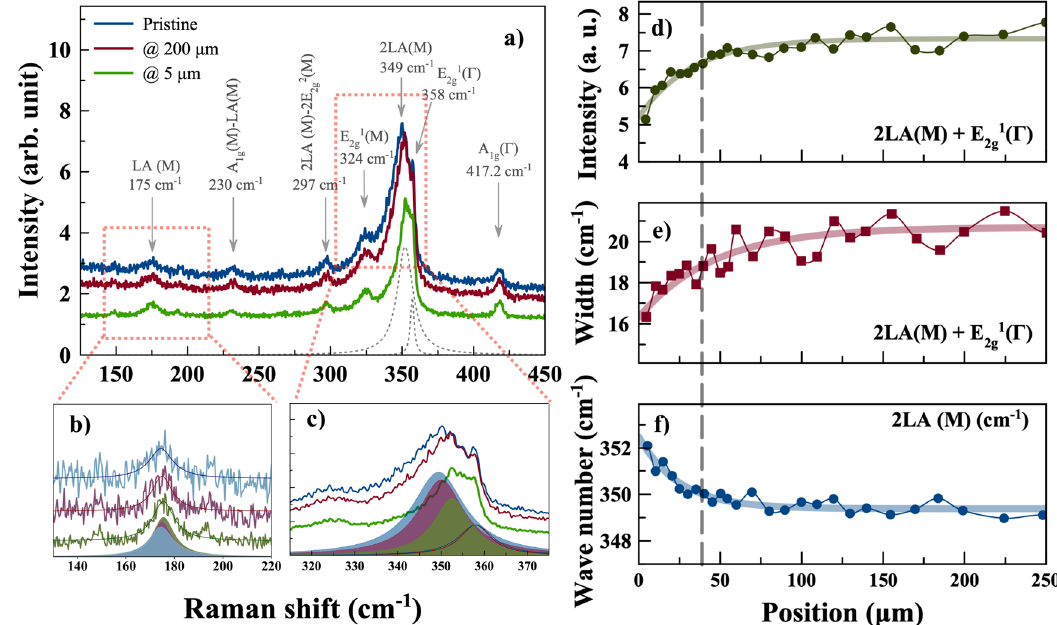
Fig. 2 Raman spectroscopy. a Raman spectra of pristine and FIB-milled ML WS 2 (5 and 200 μ m away from the milled area); b zoom-in of the Raman peak (LA(M) ) at 175 cm − 1 ; c Raman peak around 355 cm − 1 deconvolved it into two peaks: 2LA (M) and ð E 1 width (full width at half maximum, FWHM) and f peak frequency of 2LA (M) as a function of lateral